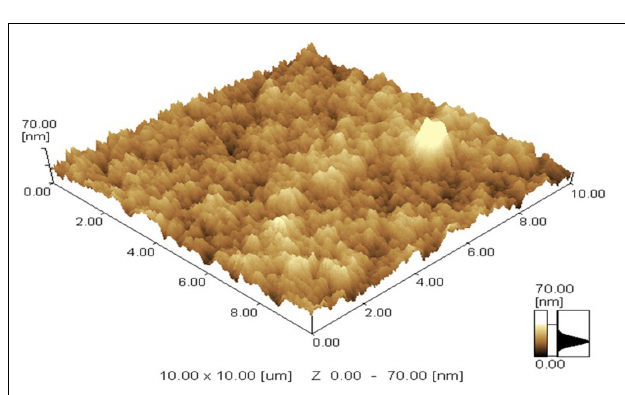
FIGURE 2 | Atomic Force Microscope (AFM) image. AFM micrograph of CSNPs was taken at room temperature. Maximum height of 70 nm was